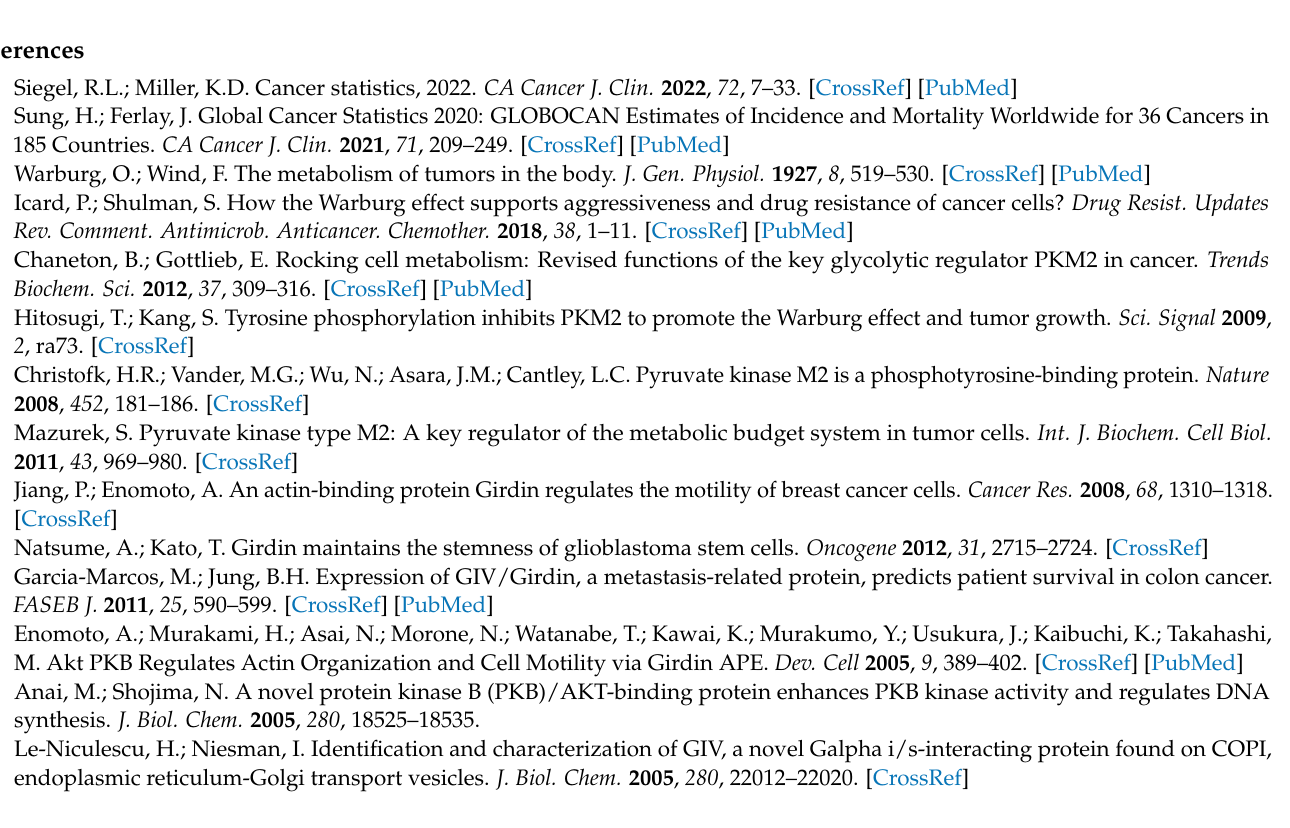
Figure 1; Figures S2–S5 are the uncropped WB figures for relevant